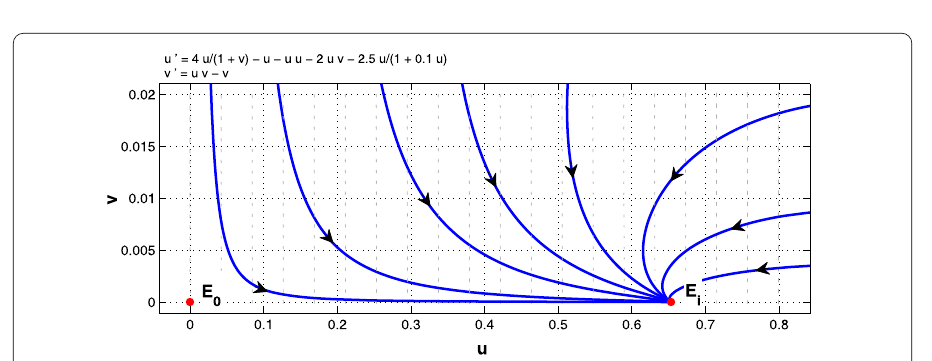
Figure 6 Dynamic behavior of system (5.1) with r 0 = 4, d = 1, k = a = m = 1, c = 0.5, p = 2, m 1 = 1, m 2 = 0.1, q = 2.5, and E = 1